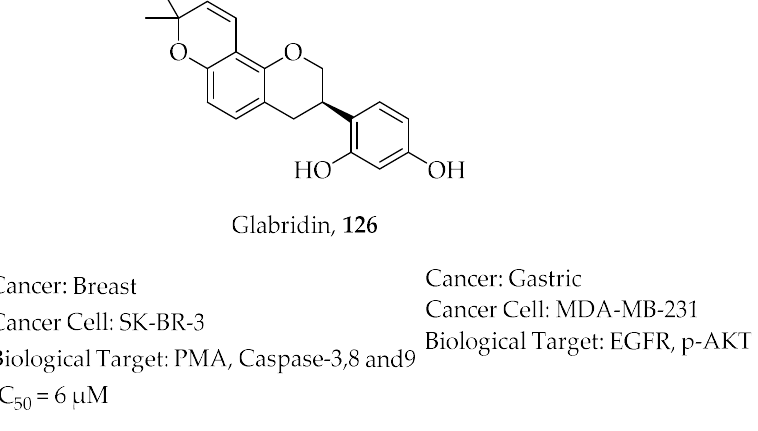
Figure 22. Structure of an isoflavonoid Glabridin with a summary of its biological activity towards selected cancer targets.